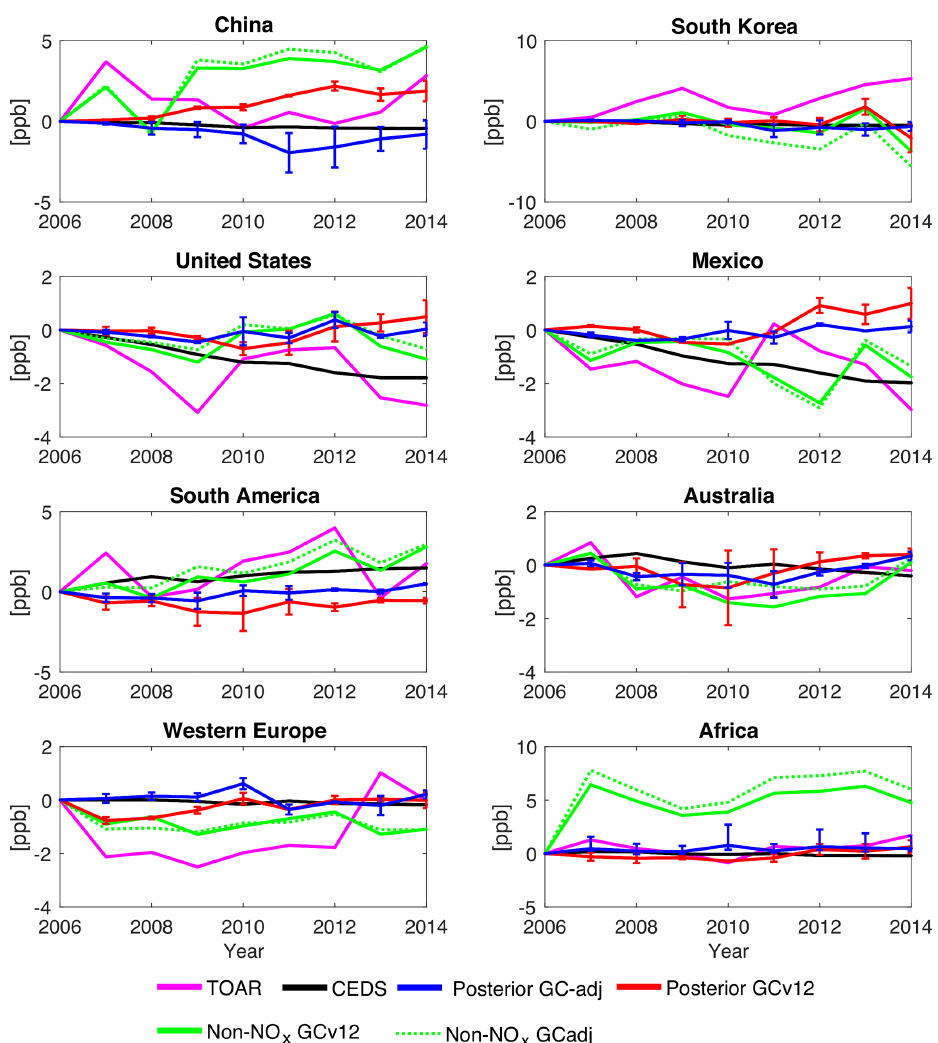
Figure 9. Changes of regional mean annual MDA8 ozone concentrations compared to 2006 from TOAR measurements (magenta line), due to changes in bottom-up NO x emissions (black), due to changes in top-down NO x emissions (blue lines for simulations from GC-adj and red lines for simulations from GCv12), and due to changes in meteorology and non-NO x emissions (green lines). Only sites that have continuous measurements throughout the 9 years are included. The vertical bars represent the spread of changes from simulations using the NASA and the DOMINO posterior NO x emissions. The impacts of meteorology and natural sources are removed from black, blue, and red lines by subtracting simulations using 2010 bottom-up anthropogenic emissions for all years from simulations that use bottom-up NO x emissions corresponding to each